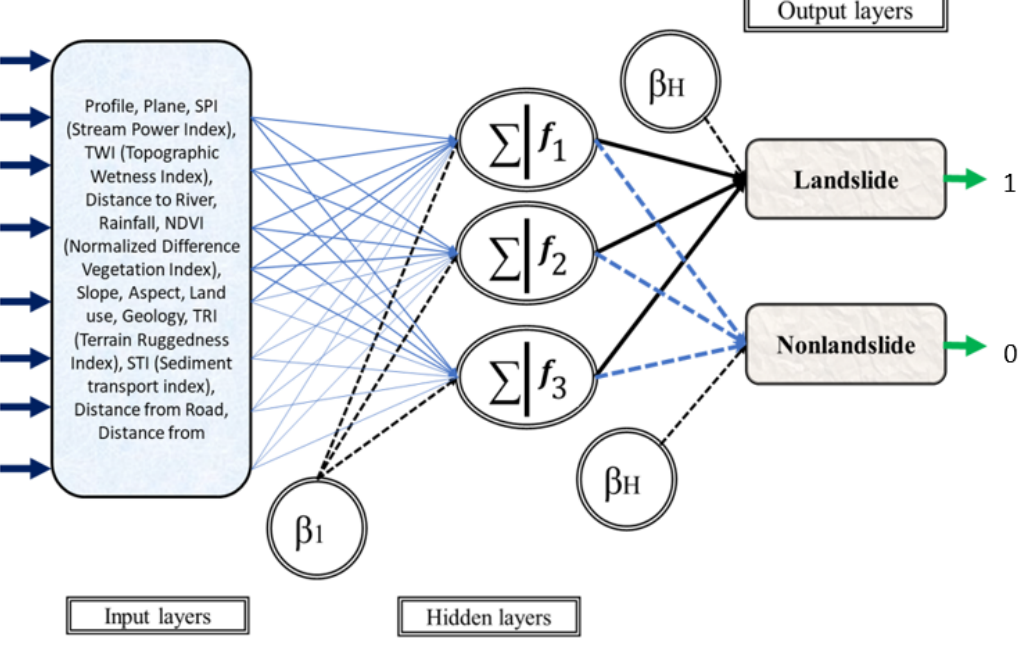
Figure 2. Basic structure of neural network for landslide susceptibility analysis with optimization Figure 2. Basicstructureofneuralnetworkforlandslidesusceptibilityanalysiswithoptimization algorithms.